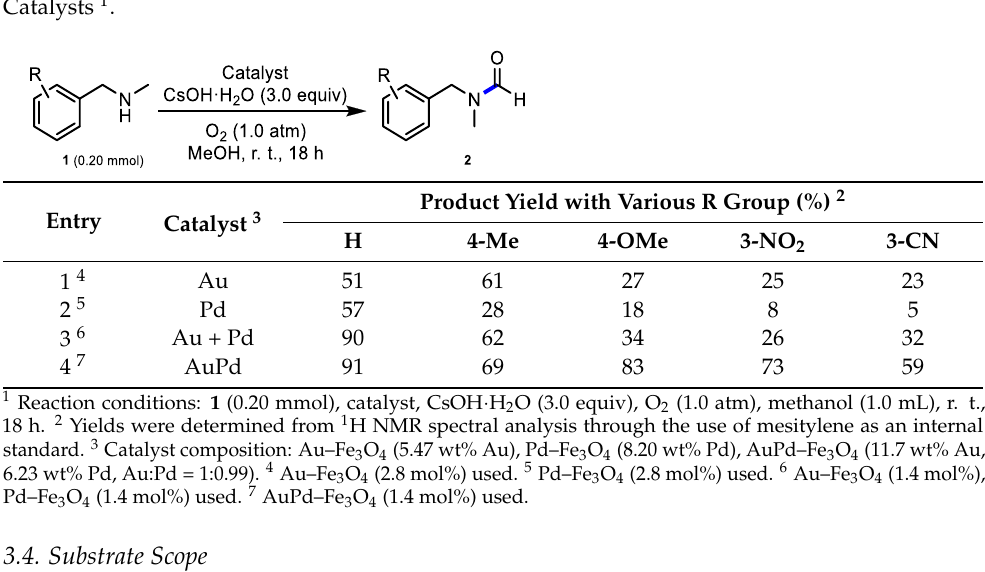
Table 3. Comparison on the Effect of Alloy Bimetallic Catalyst and Combination of Two Metal Catalysts 1 .